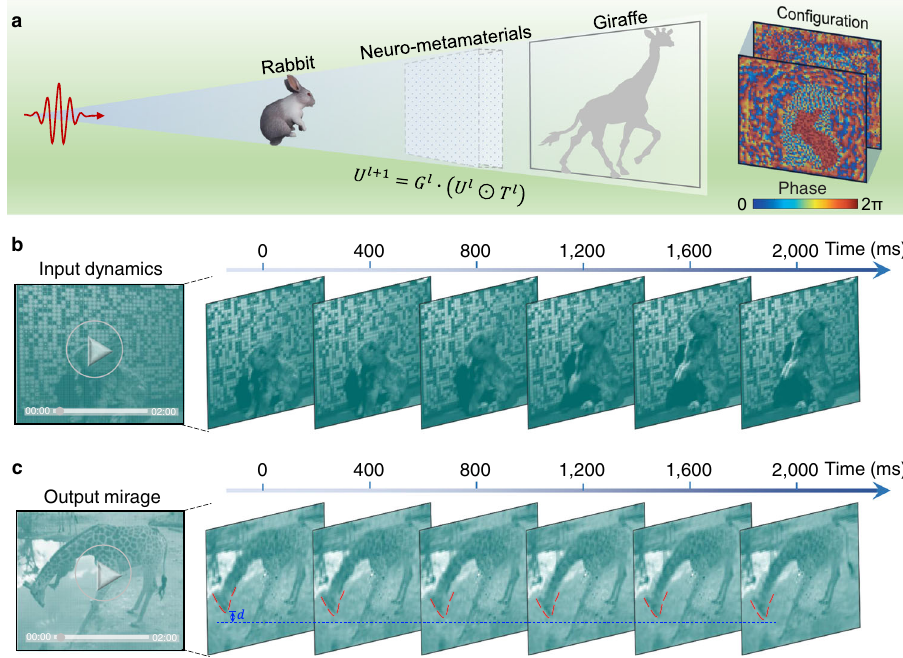
Fig. 4 Dynamic optical mirage. a Schematic of a novel optical mirage enabled by neuro- metamaterials. As compared with the mainstream transformation optics-based optical illusion, such a scheme is more practically feasible and valid for both static and non-static objects. In this example, we aimed to convert a sequence of rabbit movements into a mirage of a giraffe. The fi nal training results are shown in inset on the right-hand side of a . The formula for the inset generalizes the diffractive procedure; see details in Supplementary Note 1. b Snapshots from the video used as the input of the neuro- metamaterials (Supplementary Movie 1). c , Output mirage, implanting the rabbit ’ s motion on a giraffe drinking alongside a river. To clearly show this, we added a horizontal line in c , where the distance between the giraffe ’ s mouth and the horizontal line is labeled as d . It is obvious that d becomes smaller and smaller, and ultimately reaches zero. The entire dynamic of this mirage and the raw images can also be vividly observed in Supplementary Movie 3.